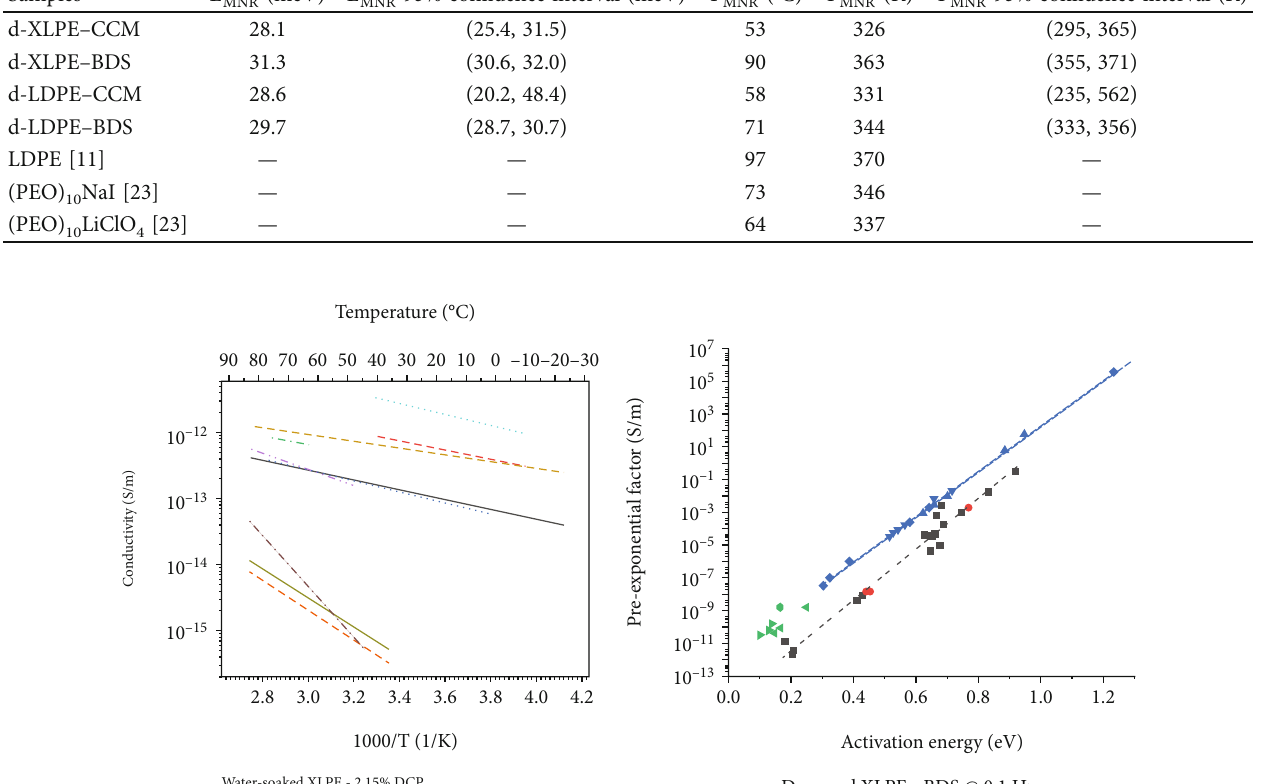
Table 1: Comparison of Meyer-Neldel energy between degassed polyethylene samples and literature references. Samples